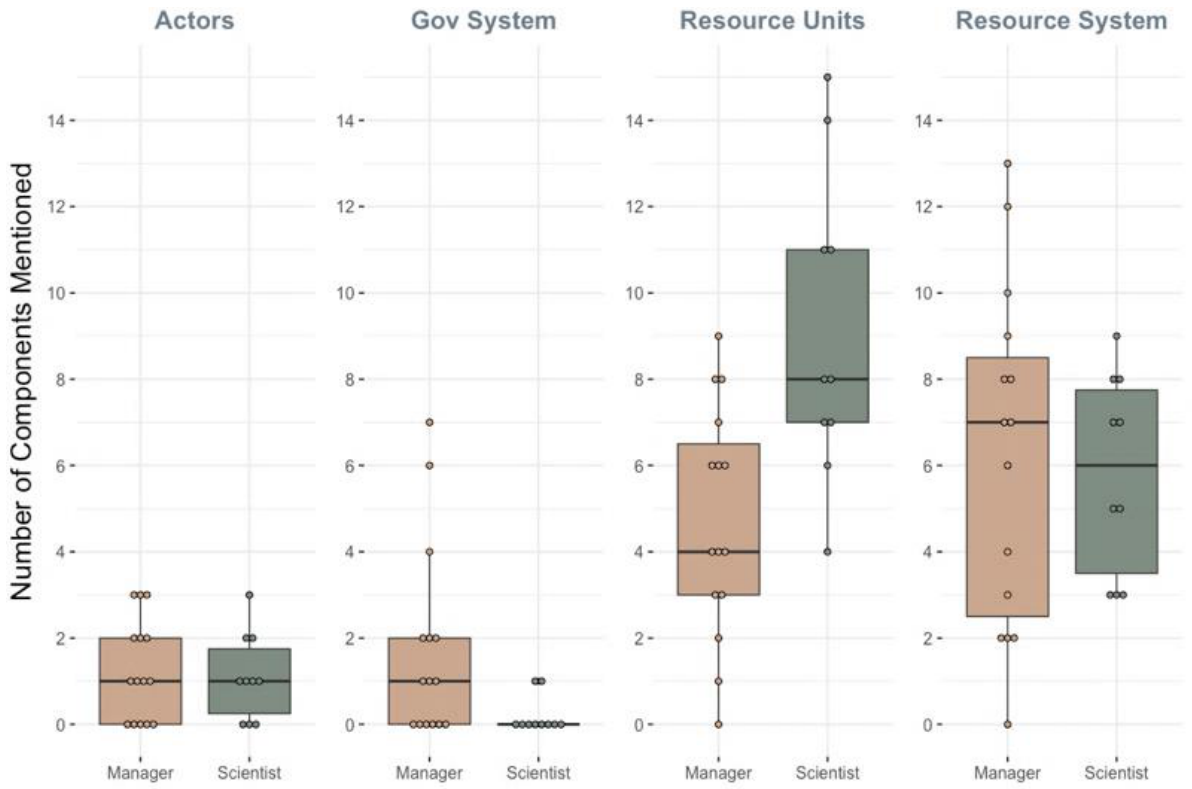
Figure 4. Box plot showing the number of Ostrom’s SES components mentioned by each expert. The circles represent an amount mentioned by an expert. The top of the box represents the 75th percentile, the bottom of the box represents the 25th percentile, and the line in the middle represents the 50th percentile. The whiskers represent the highest and lowest values that are not outliers. The circles beyond the whiskers represent outliers.